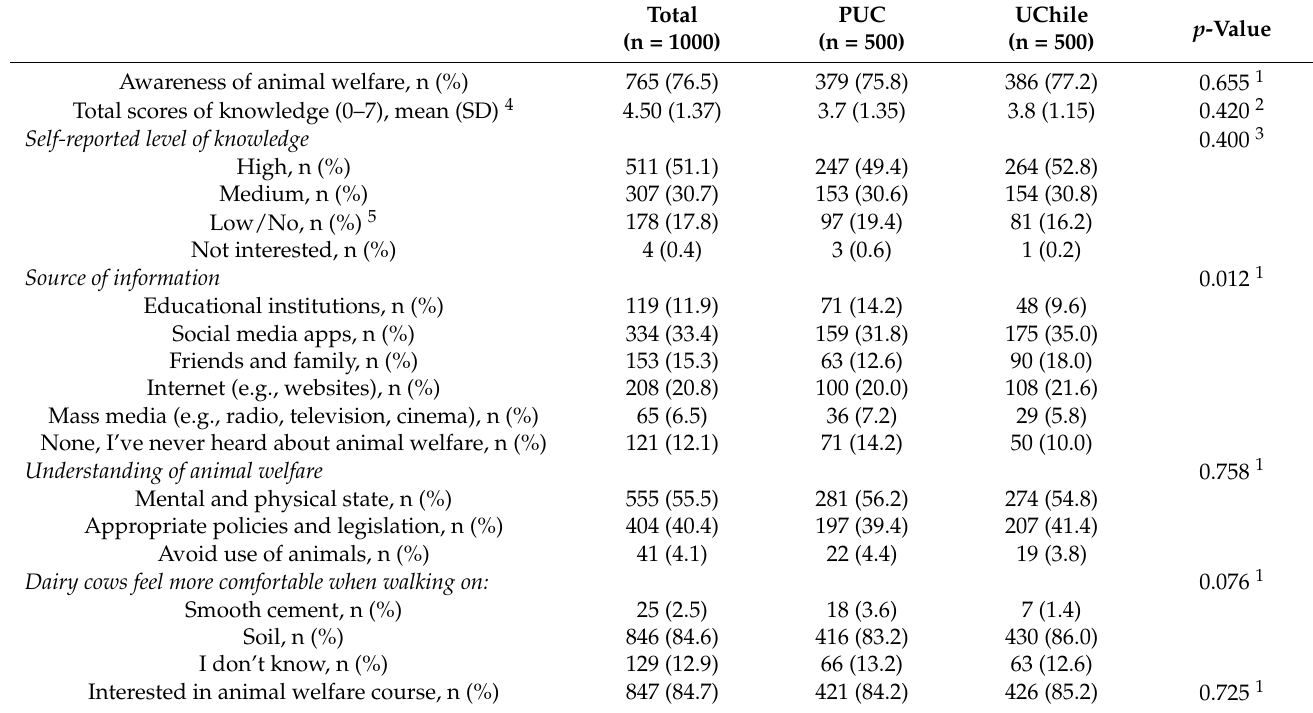
Table 2. Awareness and knowledge of animal welfare of students from Pontificia Universidad Cat ó lica de Chile (PUC) and Universidad de Chile